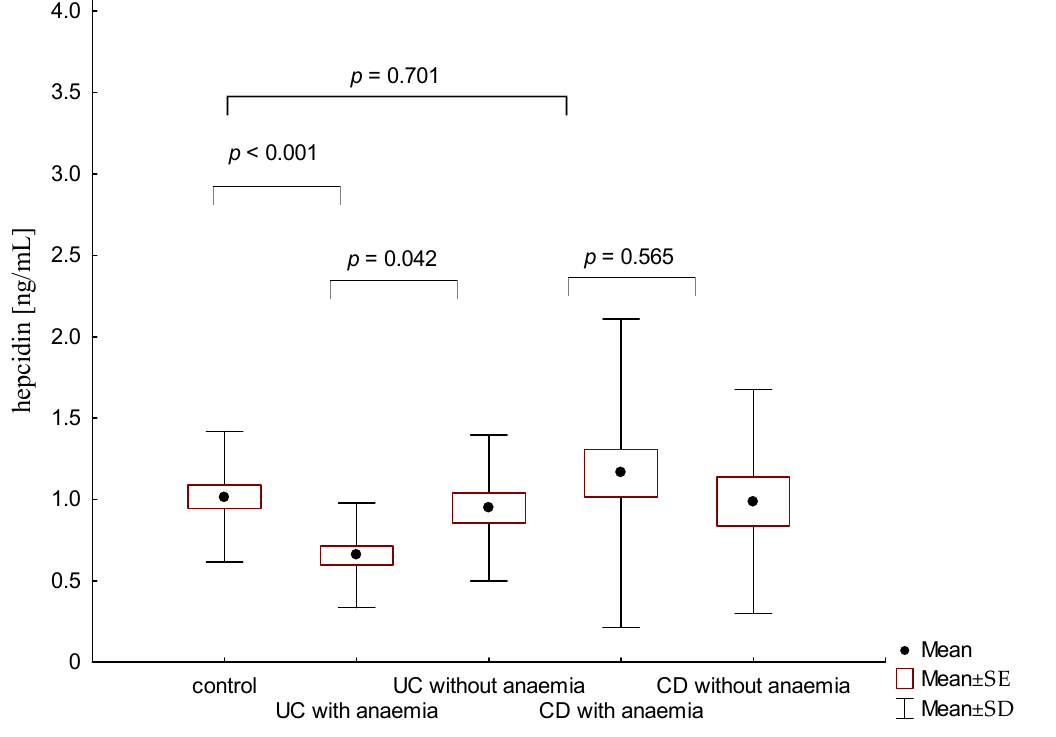
Figure 4. The concentration of hepcidin in patients with ulcerative colitis (UC) and Crohn’s disease (CD) with or without anaemia in relation to the control group.